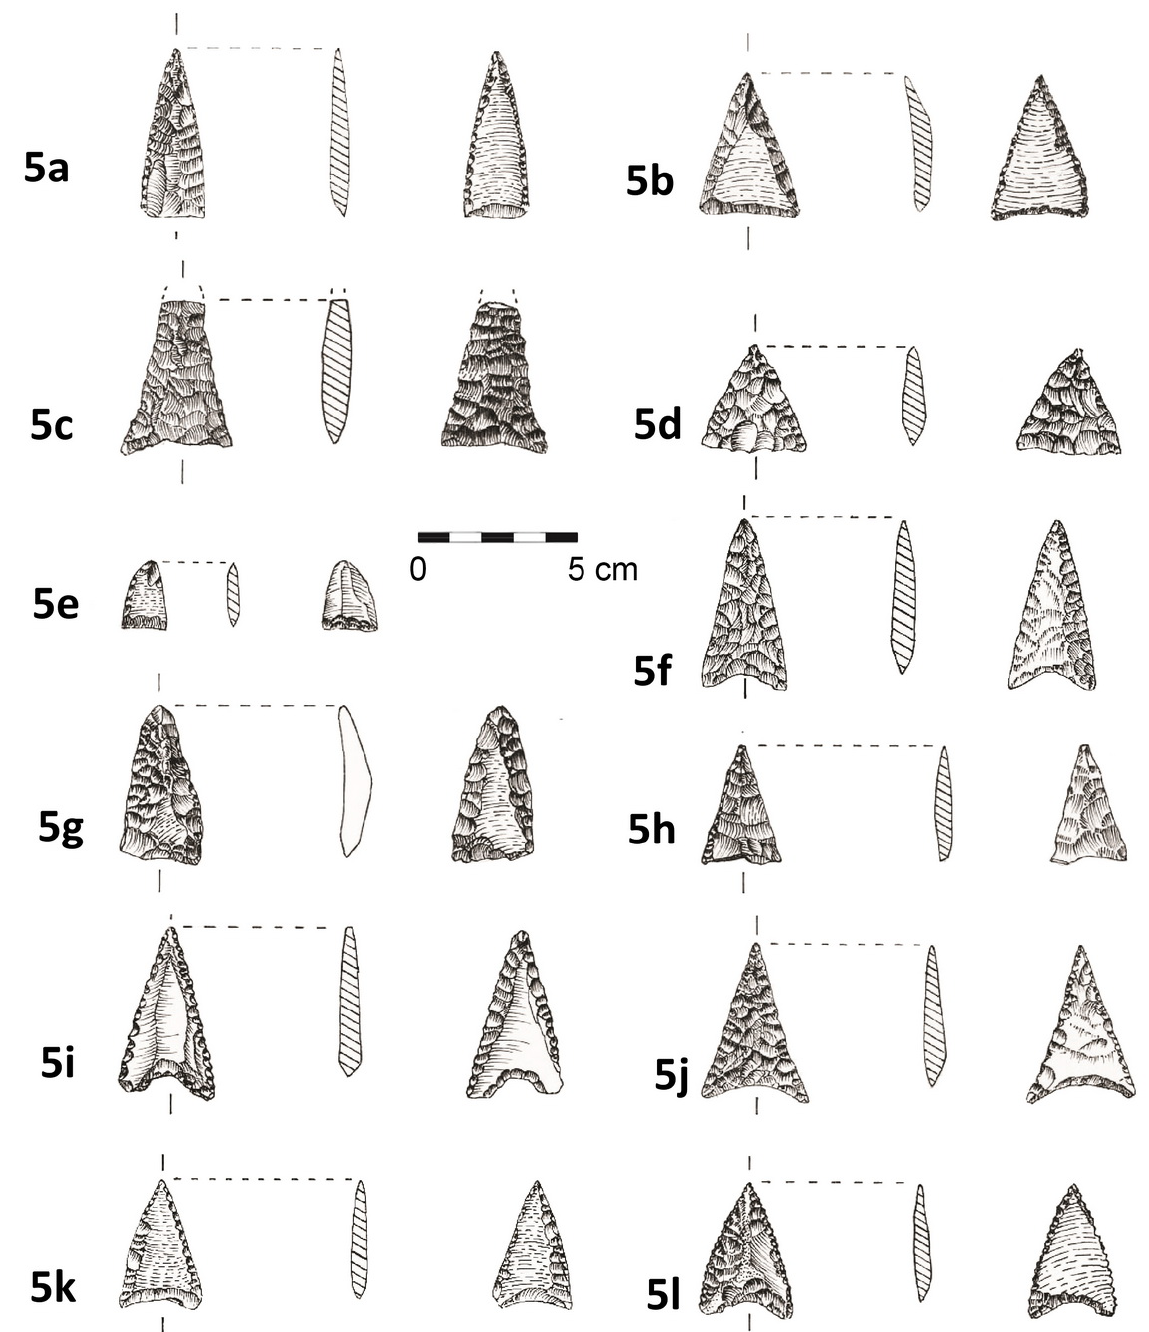
Figura 5. Pontas de seta triangulares de base recta em sílex (5a a 5e; 5g) e pontas de seta triangulares de base côncava em sílex (5f; 5i a 5l). Desenhos de Leonel Trindade Jr. Figure 5. Flat base triangular flint points and concave base triangular flint points (5h to 5l). Drawing by Leonel Trindade